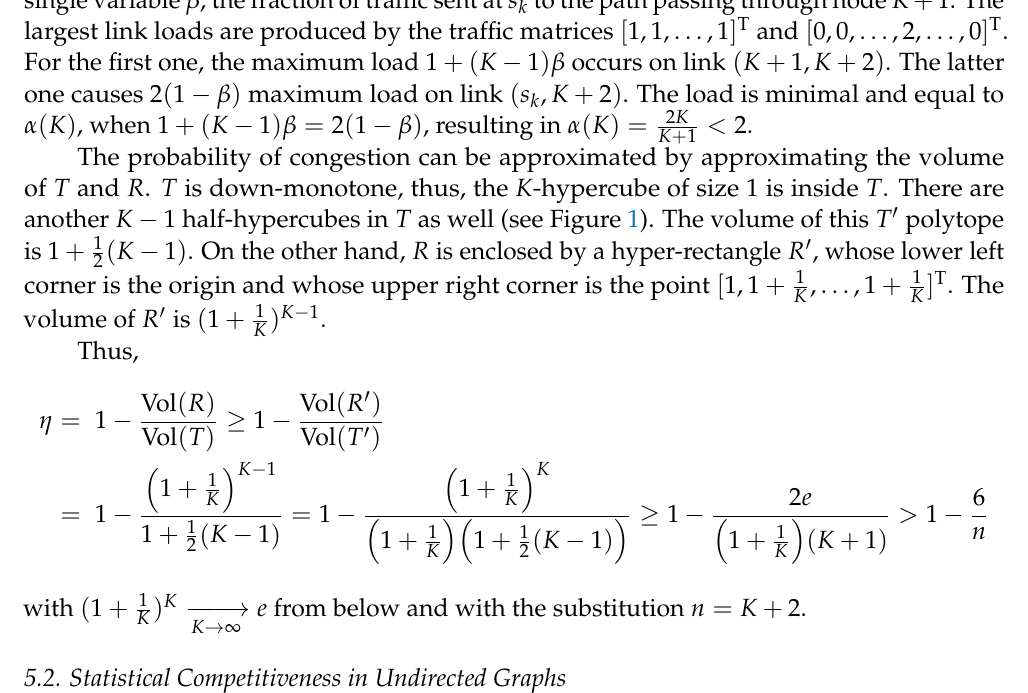
Figure 2. Undirected graph (a) and polytopes T and R (b) illus- trating the proof of Theorem 1 for K = 3.